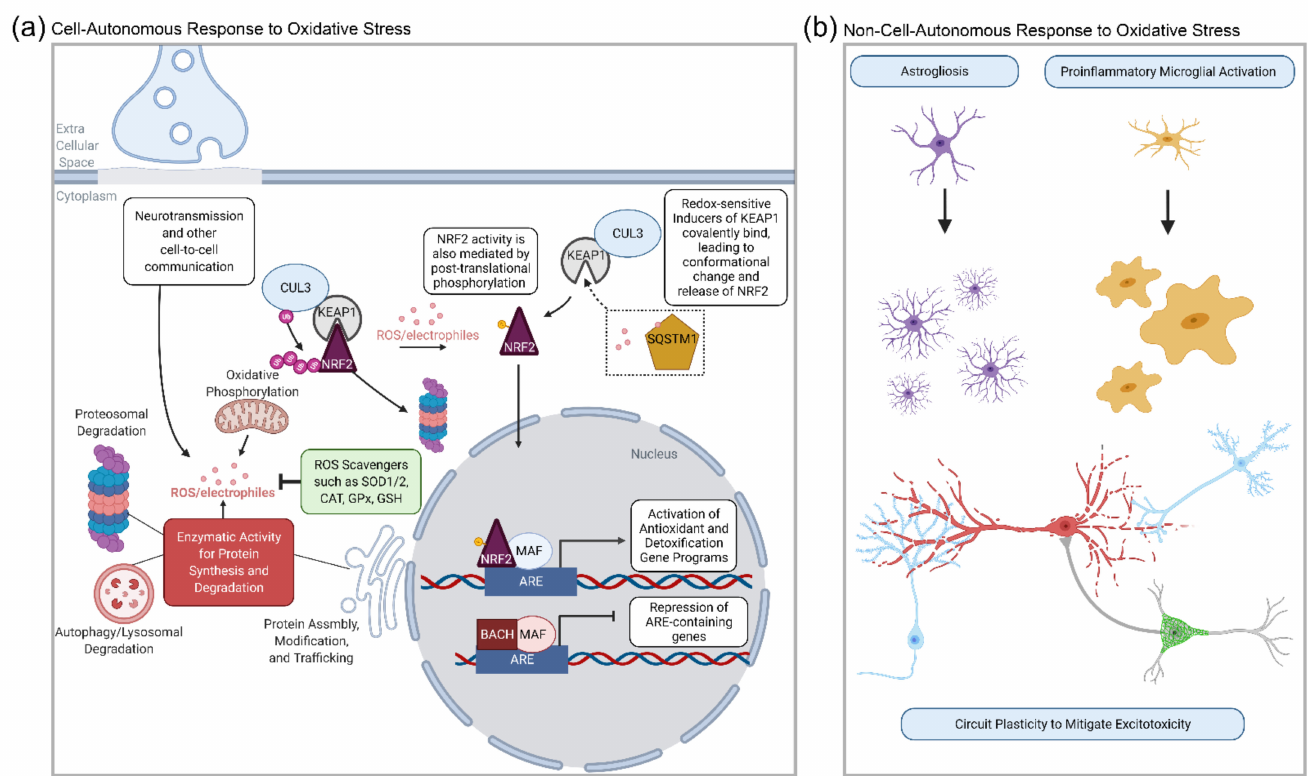
Figure 1. Schematic of canonical factors in cell-autonomous sources of oxidative stress and response are shown in ( a ). At basal state, transcription factor NRF2 is sequestered in the nucleus by the KEAP1 ubiquitination complex; here, CUL3 ligase activity leads to poly-ubiquitination of NRF2 for its targeted proteasomal degradation. Oxidative stress leads to a conformational change in KEAP1, and NRF2 is released to be phosphorylated and translocated into the nucleus to activate antioxidant response gene programs. Examples of non-cell-autonomous mediators of oxidative stress are shown in ( b ). Created with BioRender.com (accessed on 21 October